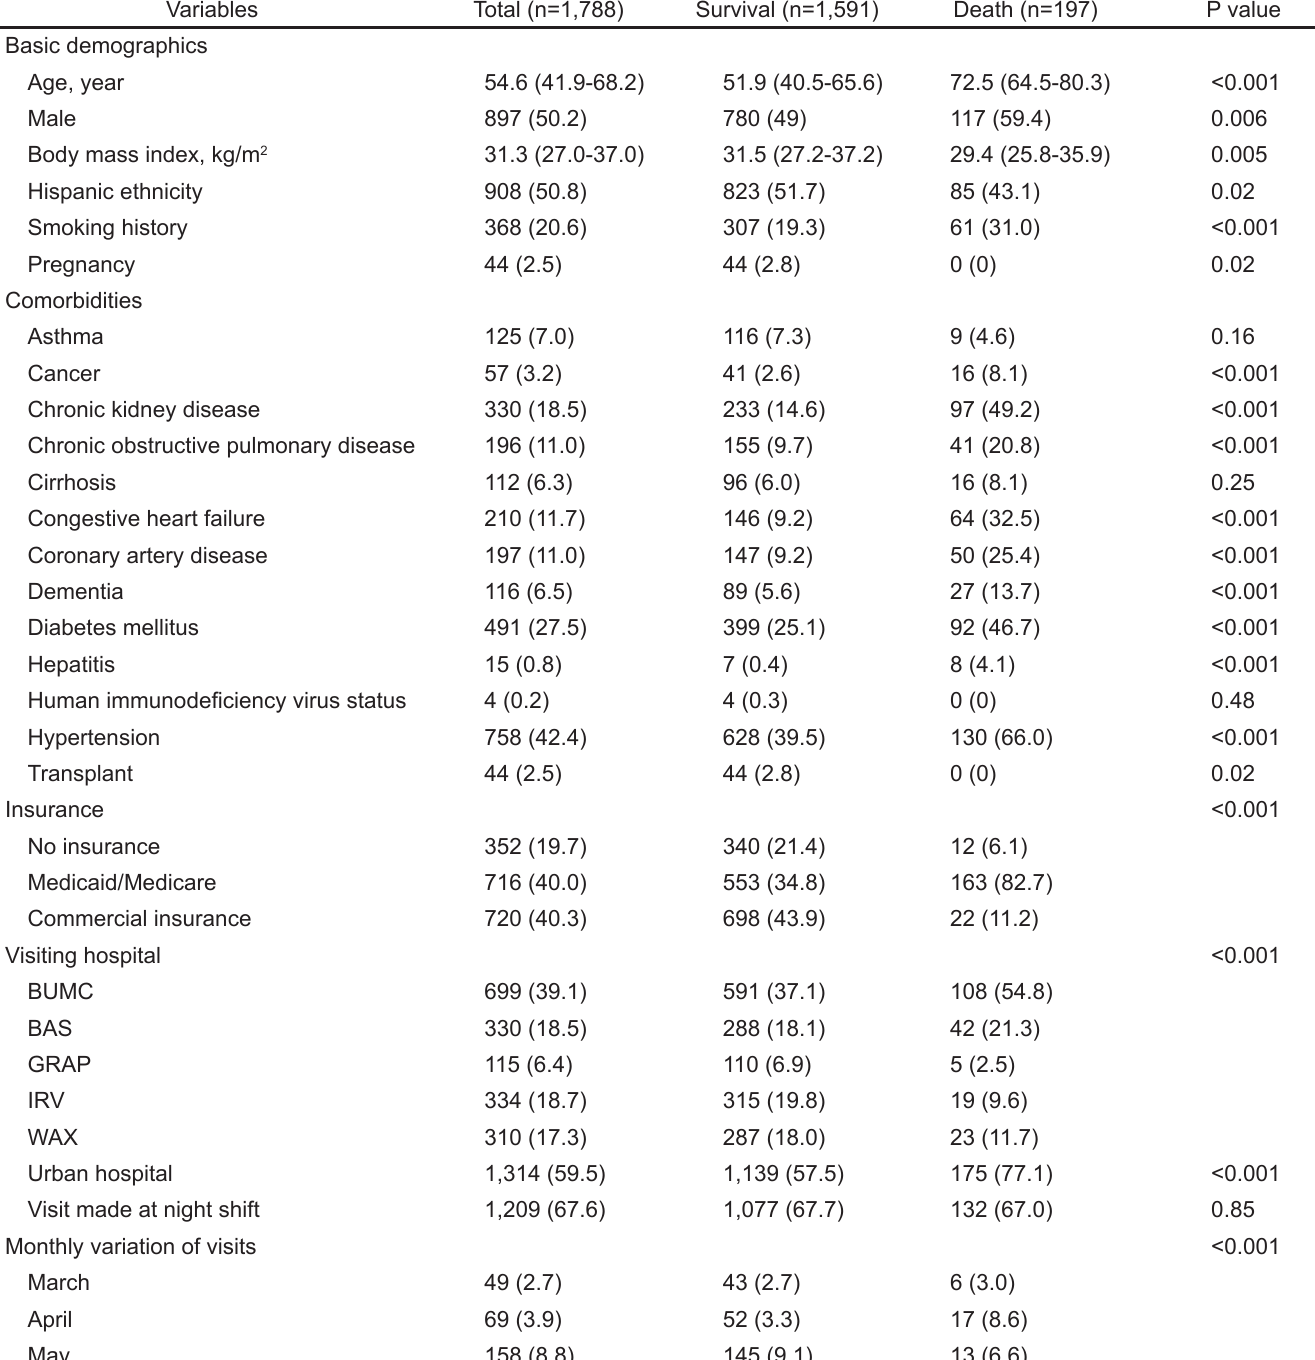
Table 1. Characteristics of patients with COVID-19 presenting to the emergency